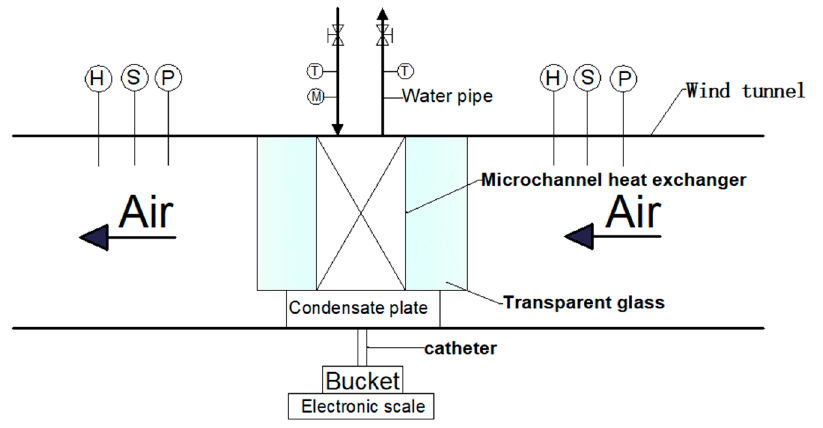
Figure 1. Schematic diagram of the minichannel heat exchanger test rig.